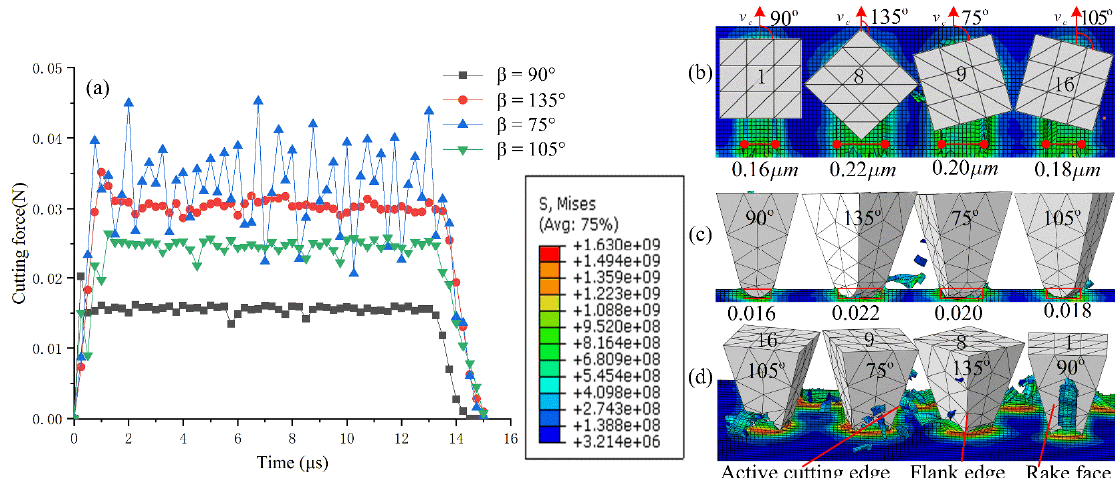
Figure 10. Effect of orientation angle on cutting force and material removal. ( a ) Honing force of different orientation angles; ( b ) Width of honing with different orientation angles; ( c ) Material removal rate of different orientation angles abrasive grains; ( d ) Influence of grain orientation angles on chip geometry .